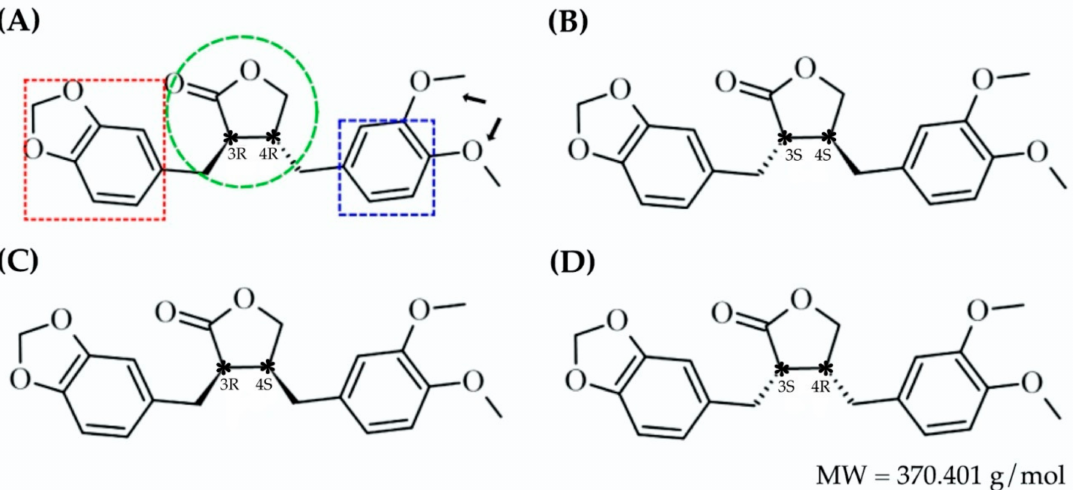
)-kusunokinin; ( B ) trans -(+)- isomer; −